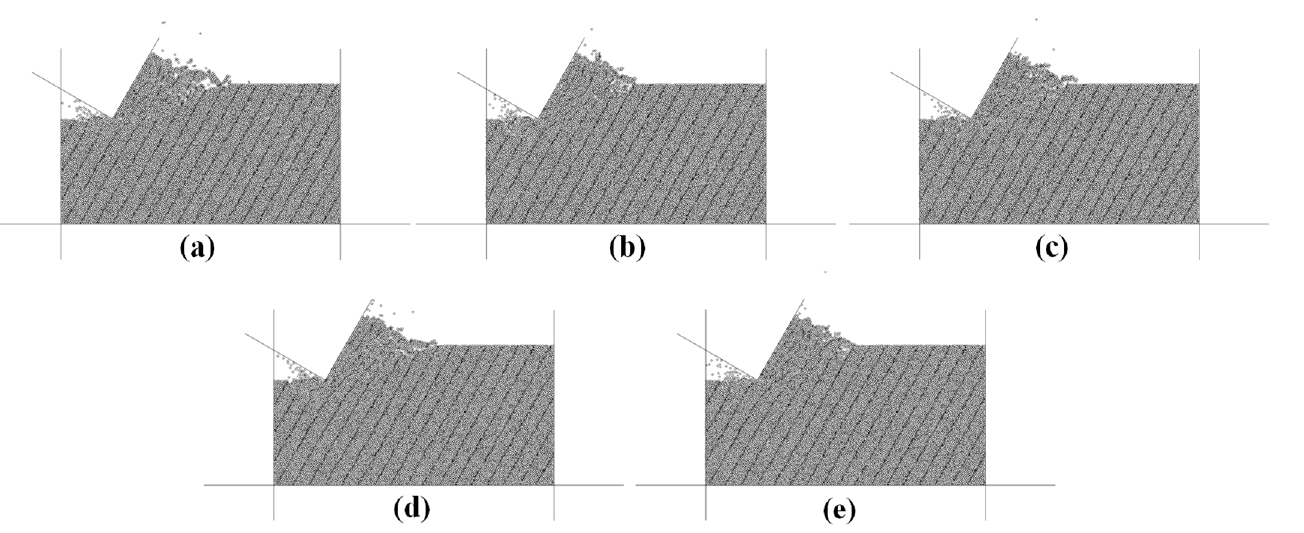
Figure 19. Cutting force vs. cutting distance curves at different cutting rates. ( a ) Horizontal compo- nent vs. cutting distance; ( b ) vertical component vs. cutting distance. Figure 20 shows the effect of cutting rate on the crack distribution of the sample; with the increase in cutting rate, the crack propagation area continuously increases. When the cutting rate further increases, the crack propagation area no longer increases. It is reason- able to speculate that this phenomenon is mainly because as the cutting rate increases, the cutting force also increases relatively, and the crack gap becomes smaller under the action of extrusion, so that the crack propagation area no longer increases.